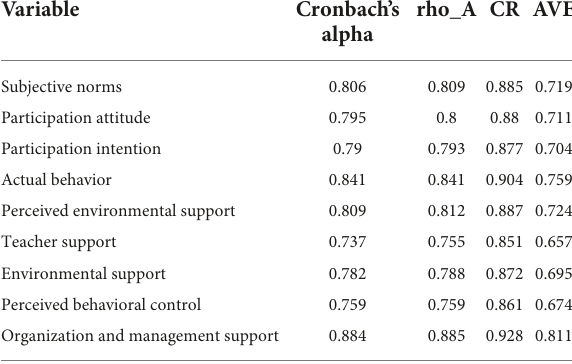
TABLE 4 Reliability and validity analysis results – CR, Cronbach’s alpha, and